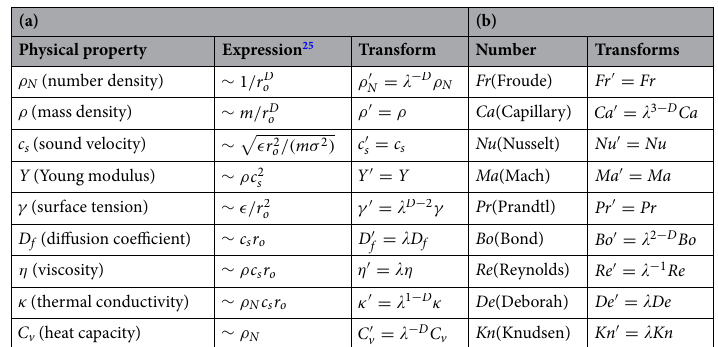
Table 1. Scale transformation rules (a) physical properties (b) the similarity law. Some dimensionless parameters are